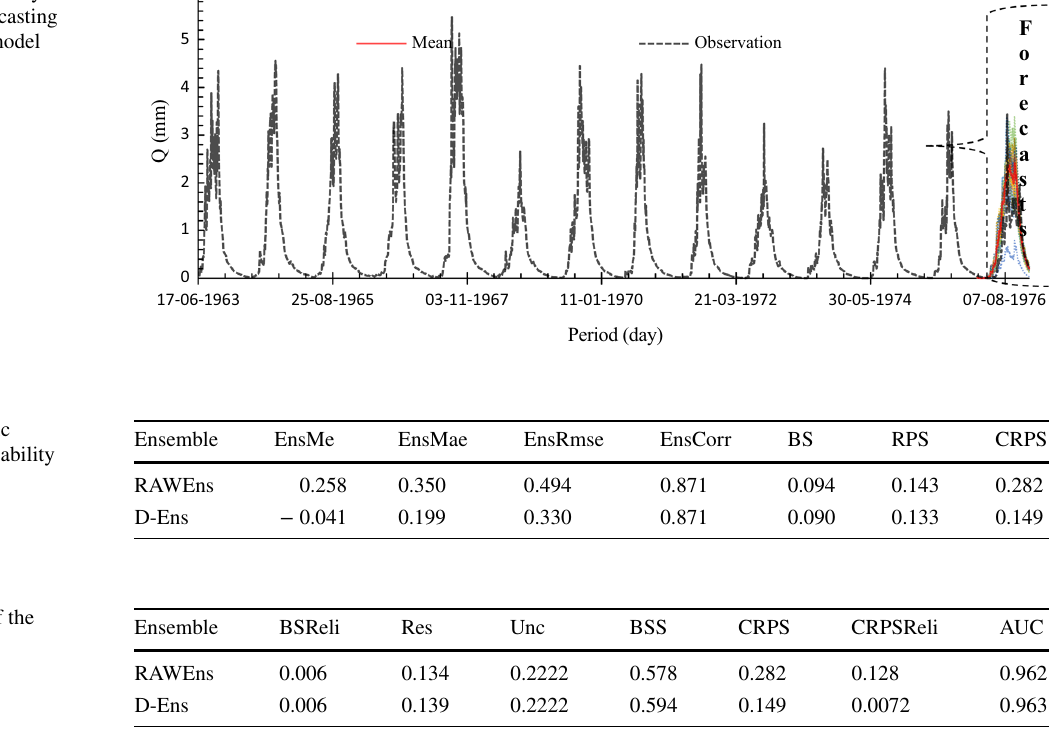
Fig. 8 Evolution of the hydro- logical ensemble forecasting from the HBV-light model